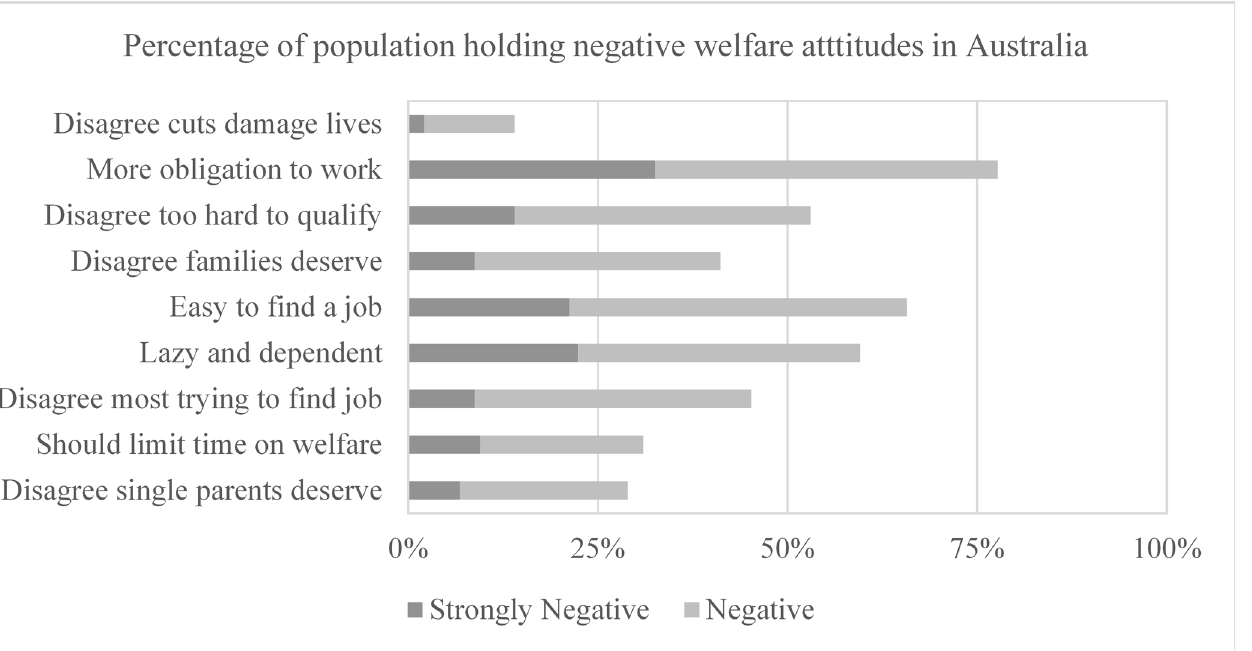
Fig 1. Prevalence of negative welfare attitude responses. Five levels of response to each statement were given to respondents for each statement; strongly agree, agree, neither agree nor disagree, disagree, strongly disagree. Darker bars indicate the percentage of strongly negative responses, light bars indicate the percentage of negative responses.